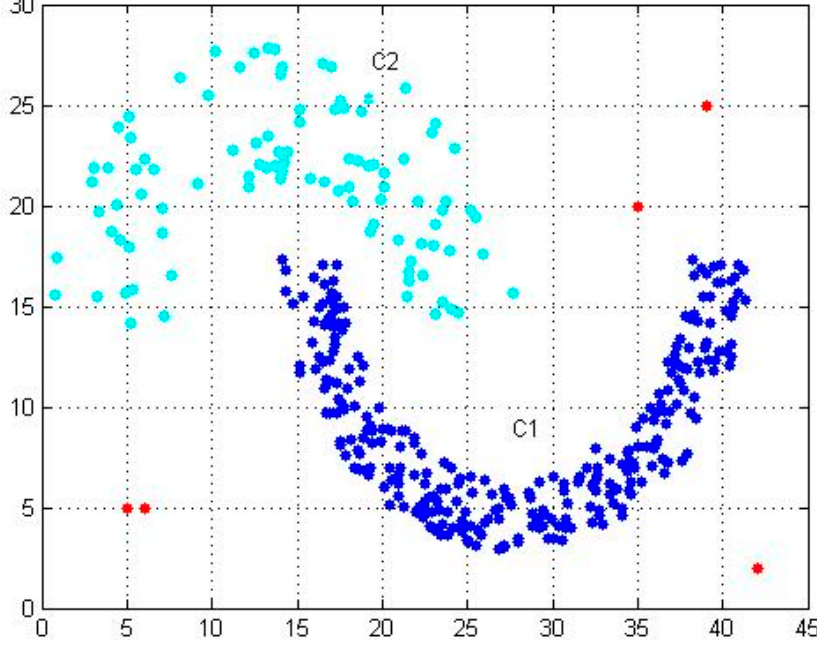
Figure 1. Existence forms of data (blue normal points are C1 and that in blue-green are C2, the outliers points are red).